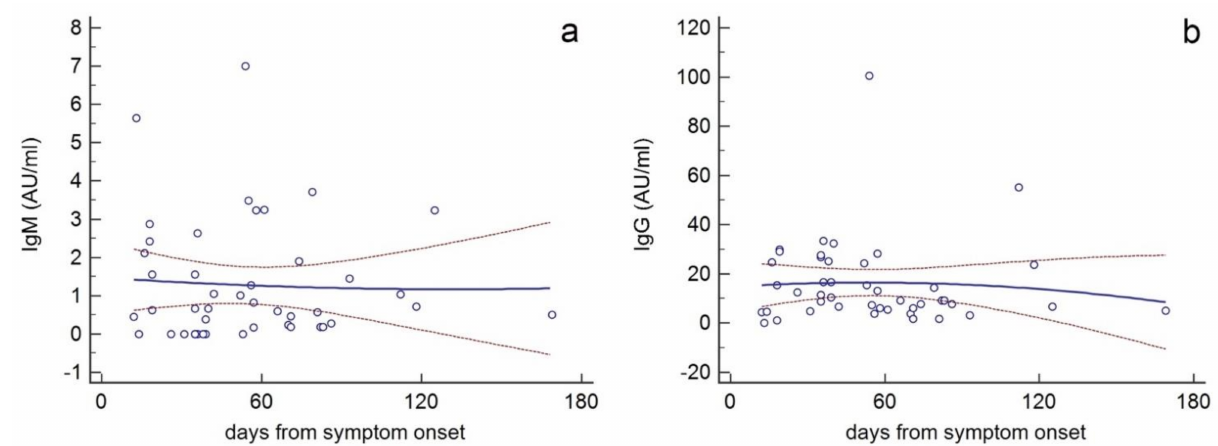
Figure 2. Scatter graphs (XY) whereby IgM ( a ) and IgG ( b ) titers (AU/mL) from all subjects were plotted against time (days after symptom onset). IgM and IgG values were interpolated by polynomial approximations (solid lines) with their confidence interval (95%) (red dotted